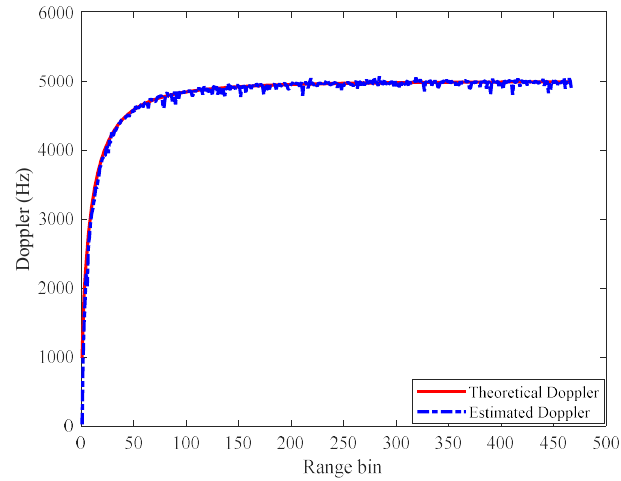
Figure 10. Theoretical and estimated Doppler frequency.